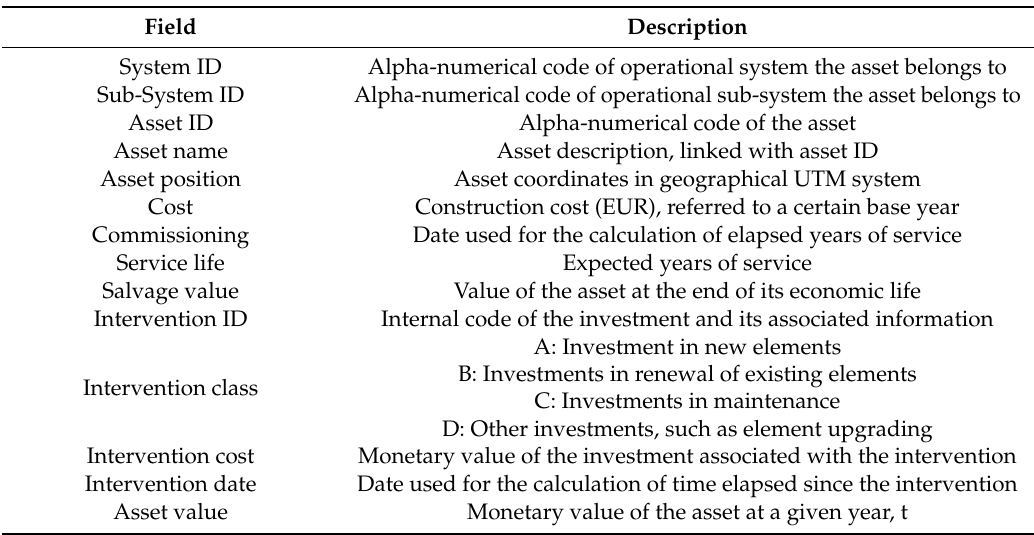
Table 2. Inventory Database